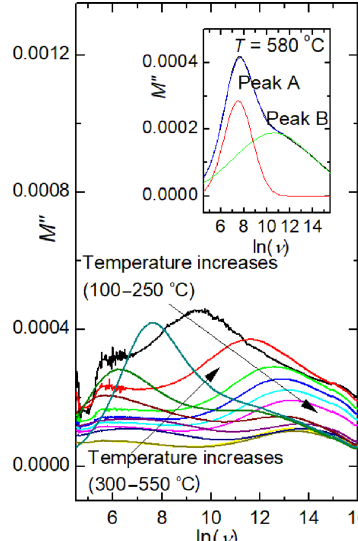
Fig. 13 Dependences of the imaginary parts of the complex modulus M" of NBT ceramics on frequency. The inset shows an example of a fit for a temperature of 580 . ℃